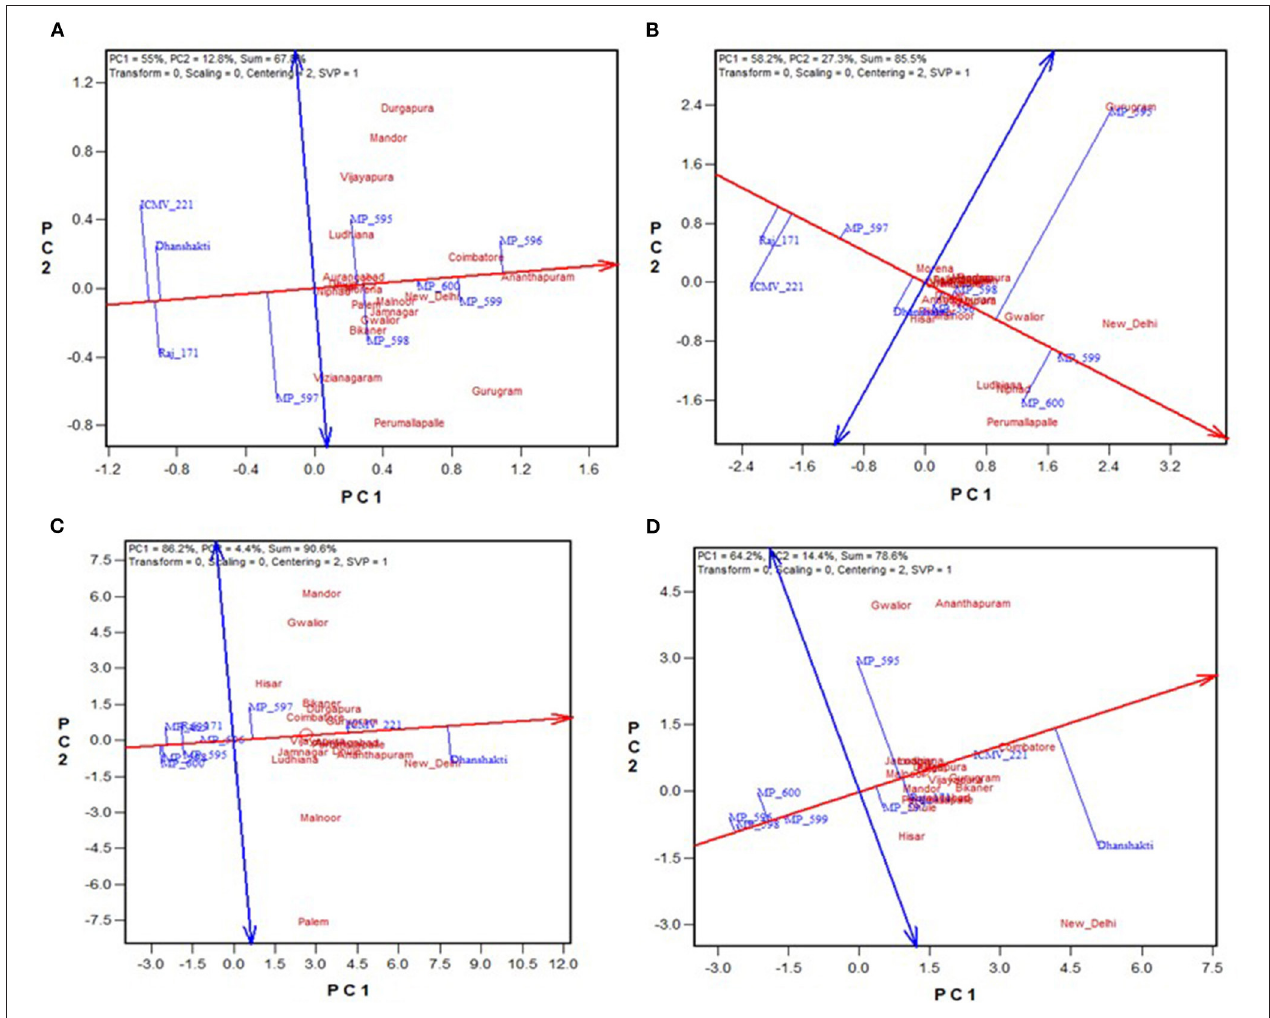
FIGURE 2 | GGE biplot showing “mean vs. stability” of nine pearl millet OPVs across 20 locations for (A) grain yield, (B) dry fodder yield, (C) grain Fe content, and (D) grain Zn